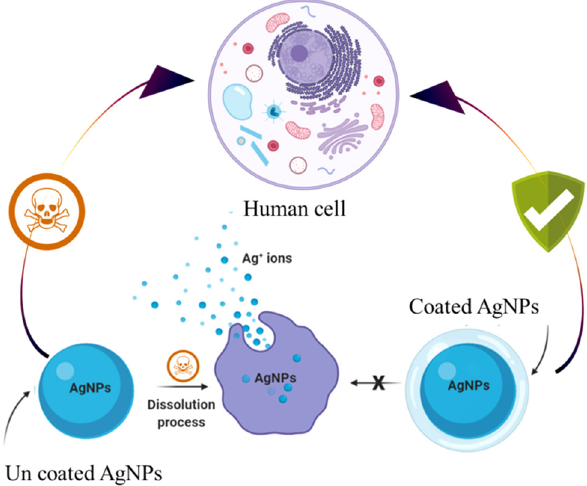
Figure 11: A scheme explaining how to limit the toxicity of silver